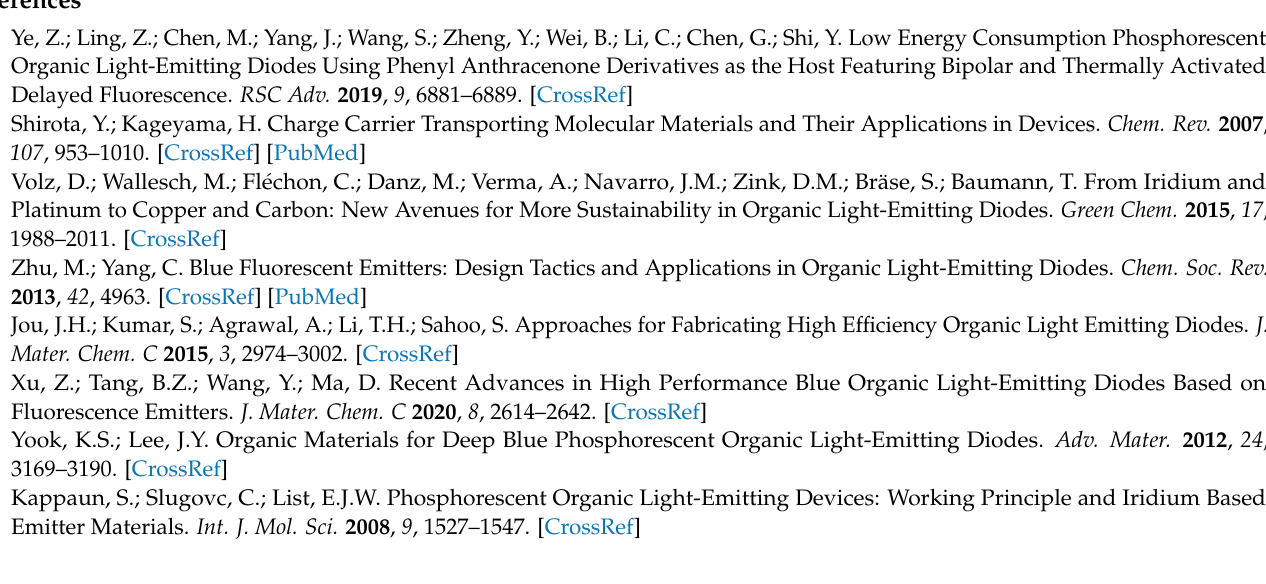
PL (b) spectra of 3 solutions. Figure S5. Absorption (a) and PL (b) spectra of 4 solutions. Figure S6. Lippert–Mataga plots for 1 (a), 3 (b) and 4 (c). Figure S7. (a–c) Phosphorescence spectrum of dilute solutions of 1 – 3 in THF at 77 K. Figure S8. PL decay curves of solutions of 1 – 4 in THF. Figure S9. PL spectra of THF solutions of 1 (a) and 3 (b), normalized PL spectra of 3 (c) before and after 40 min photoexcitation by the UV light. Figure S10. (a–d) Cyclic voltammograms of compounds 1 – 4 . Figure S11. TOF signals for holes/electrons in vacuum-deposited layers of compounds 1 – 4 at different electric fields. Figure S12. EL spectra of non-doped devices A–D at different voltages. Figure S13. Electroluminescence characteristics of OLEDs A–D: (a) current efficiency versus current density, (b) power efficiency versus current density. Figure S14. Diagram of energy levels of green PHOLEDs. 4,4 (cid:48) ,4 (cid:48)(cid:48) -tris[phenyl(m-tolyl)amino]triphenylamine (m-MTDATA) and bathophenanthroline (Bphen) were used as hole and electron transporting layers, respectively. Figure S15. Electroluminescence characteristics of PHOLEDs E–H: (a) current density and luminance versus voltage, (b) current efficiency versus current density, (c) power efficiency versus current density, (d) external quantum efficiency versus current density. Figure S16. Electroluminescence spectra of PHOLEDs E–H recorded at applied voltage of 10 V. Figure S17. EL spectra of devices I–L at different voltages. Refs. [58,59] are cited in supplementary